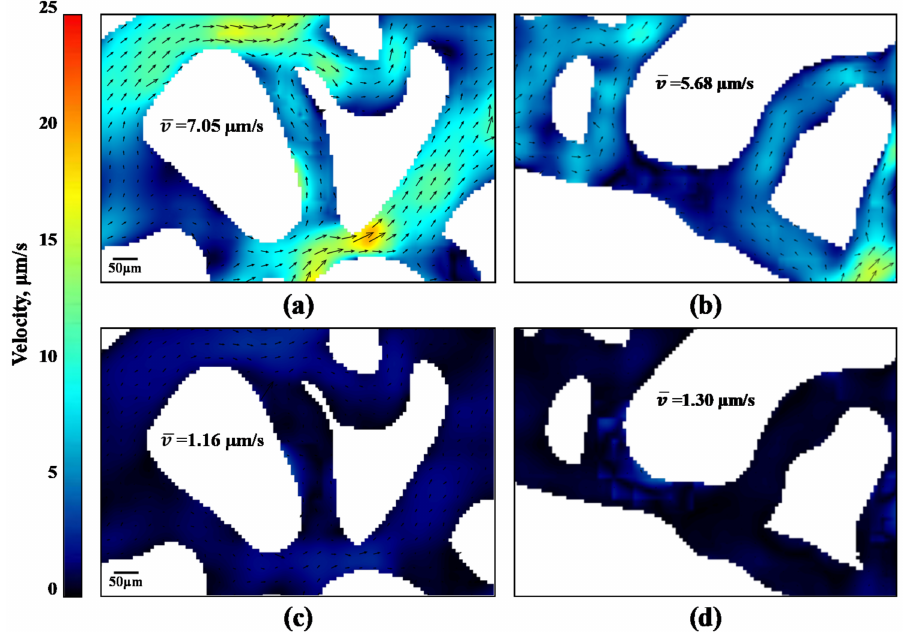
Figure 6. Velocity fields during polymer flooding without sulfide at the main stream ( a ) and margin ( b ) and during post-water flooding without sulfide at the main stream ( c ) and margin ( d ).